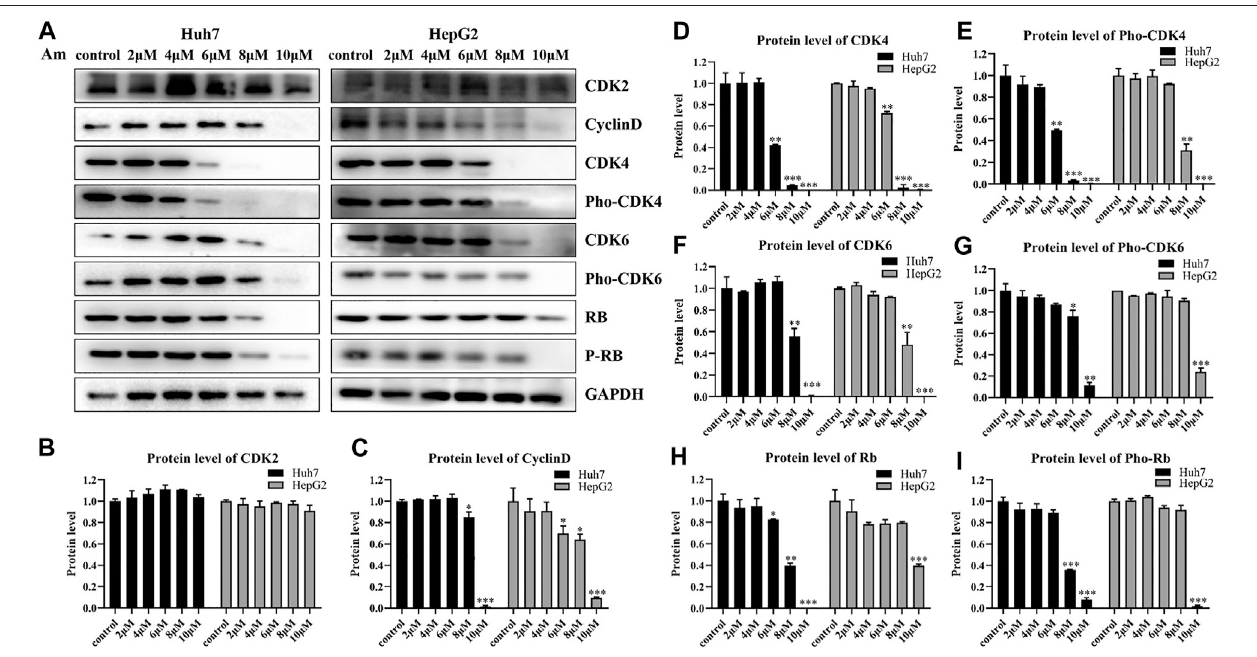
FIGURE 3 | Aminoquinol treatment decreased the expressions of CDK4/6, Rb, cyclinD, pho-Rb, pho-CDK4/6, but not CDK2 in HepG2 and Huh7 cells (A) The western blot analysis of Huh7 and HepG2 cells treated with different concentrations of aminoquinol (0, 2, 4, 6, 8, 10 μ M) for 6 h (B – I) The quanti fi ed data of protein expressions for (B) CDK2, (C) CyclinD, (D) CDK4, (E) pho-CDK4, (F) CDK6, (G) pho-CDK6, (E) Rb and (I) pho-Rb. Data were presented as means ± standard deviation.* p < 0.05, ** p < 0.01, *** p < 0.001, signi fi cantly different from the control